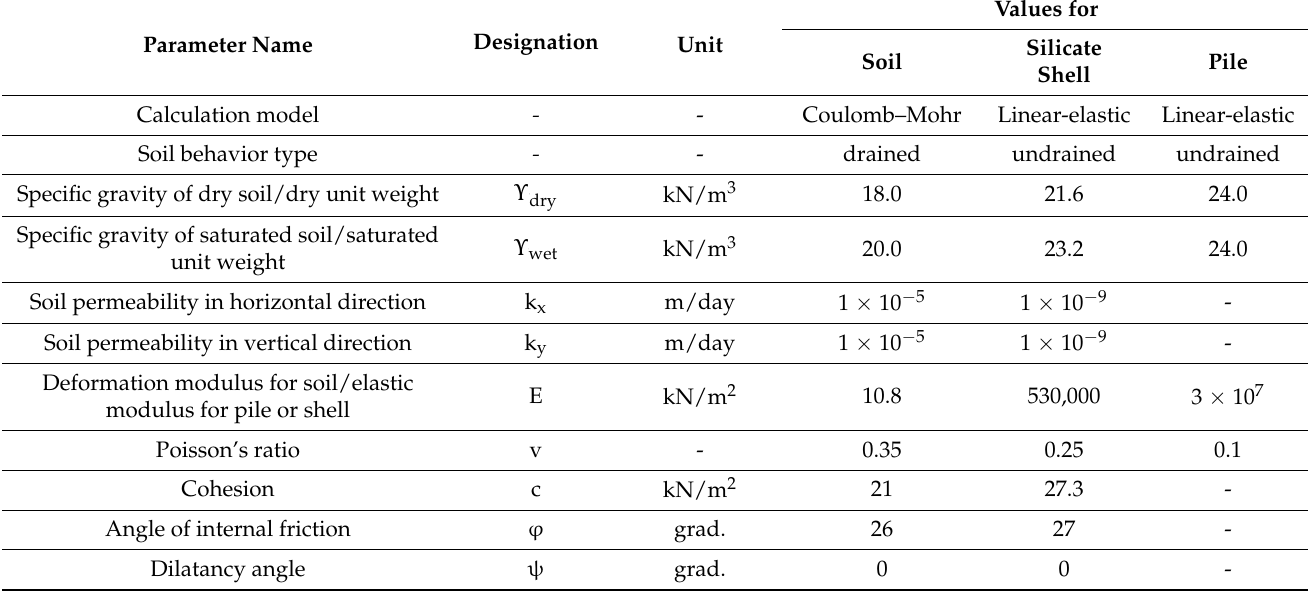
Table 5. Accepted simulation parameters.